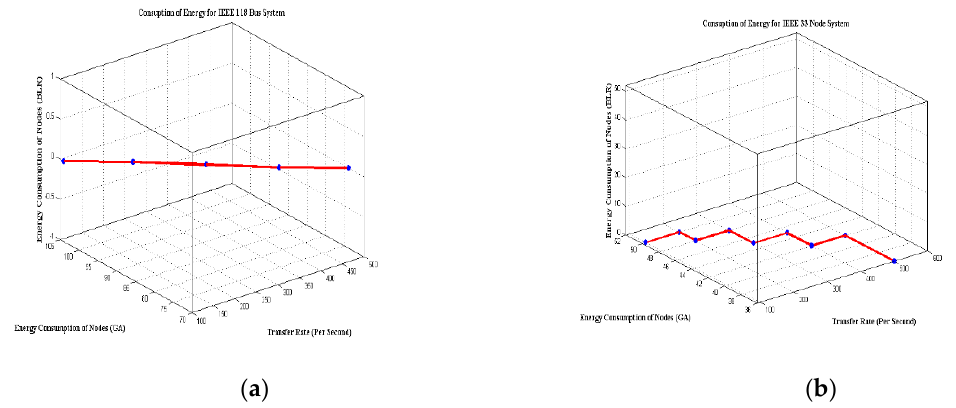
Figure 3. Energy consumption of test systems: ( a ) IEEE 118 bus and ( b ) IEEE 33 node.